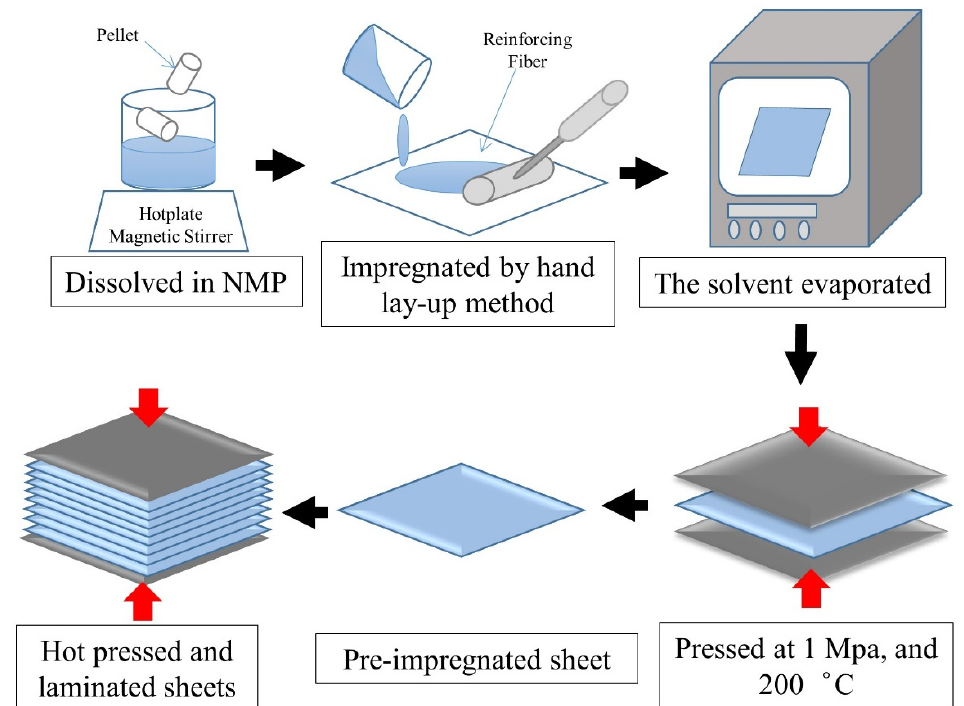
Figure 1. The schematic of preparation of thermoplastic matrix pre-impregnated sheet.